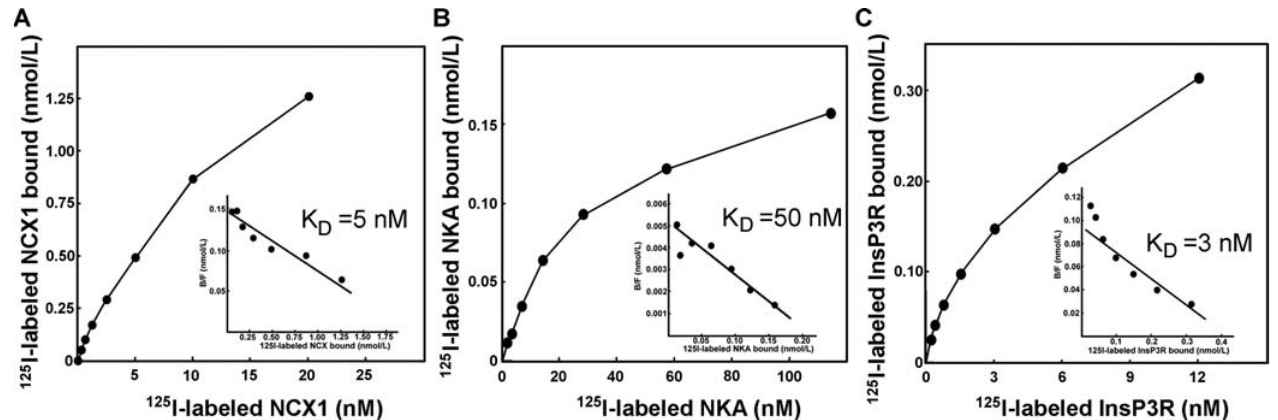
Figure 5. Purified NCX1, NKA, and InsP 3 R Directly Interact with Purified Ankyrin-B Membrane-Binding Domain Saturation binding of purified (A) 125 I-labeled NCX1, (B) 125 I-labeled NKA (NKA), and (C) 125 I-labeled InsP 3 R with glutathione Sepharose–immobilized GST-ankyrin-B membrane-binding domain or GST control Sepharose. Inset for each panel represents Scatchard analysis of ankyrin-B interactions following subtraction of nonspecific binding to GST-Sepharose. Proteins were isolated as described in Materials and Methods. DOI: